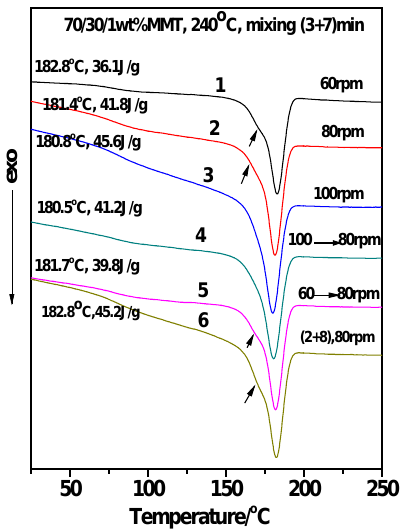
Figure 7. The influence of shear rate on the crystallization of the 70/30/1 wt. % PTT/PC/MMT blend processed at 240 °C for 10 min. The MMT is Cloisite ® 25A.